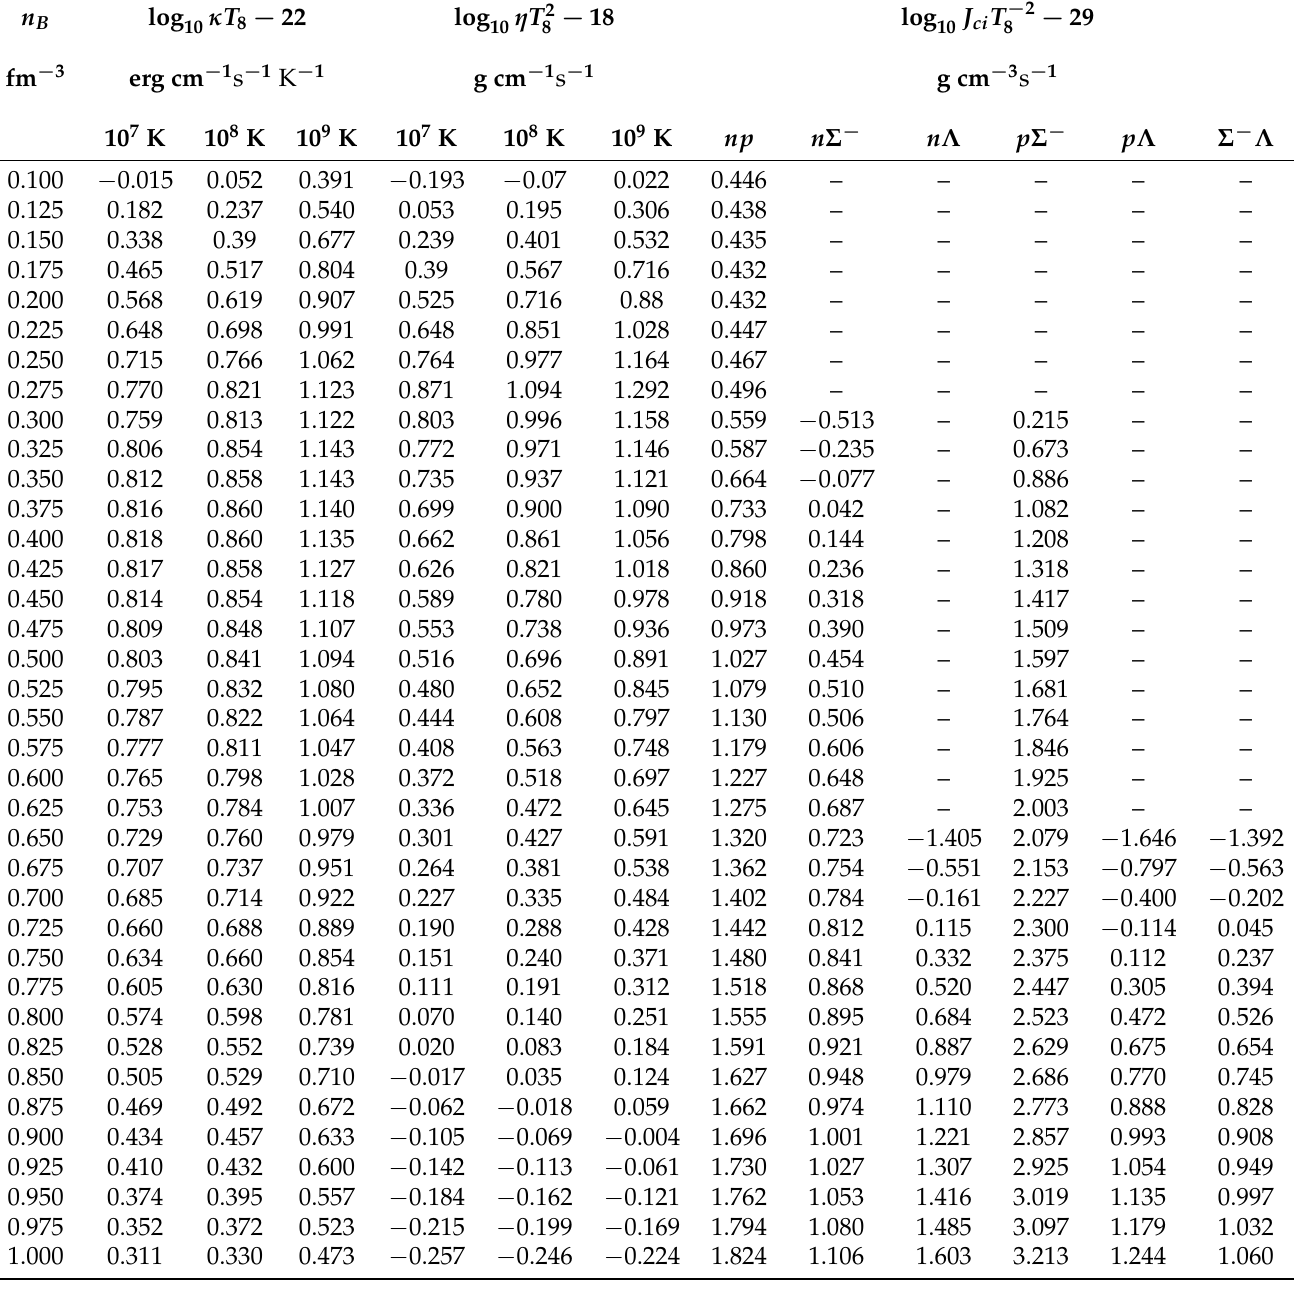
Table A4. Same as Table A3 but for the NSC97a